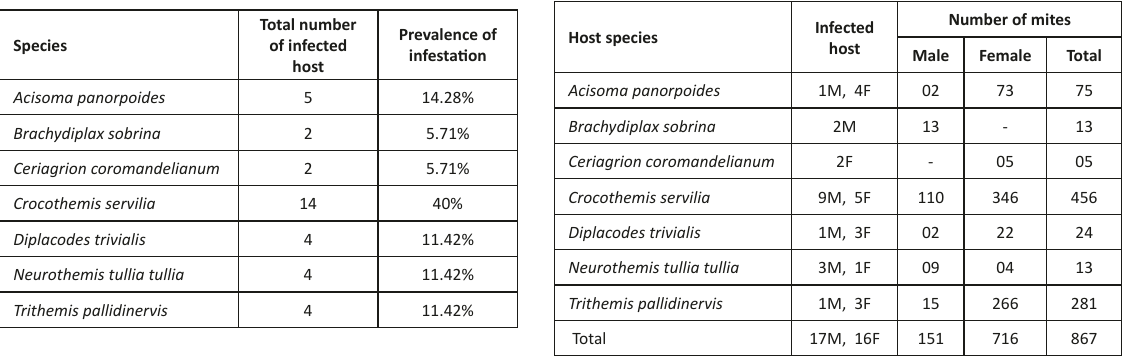
Table 3. Number of Arrenurus aquatic mites on male and female odonates of Wena